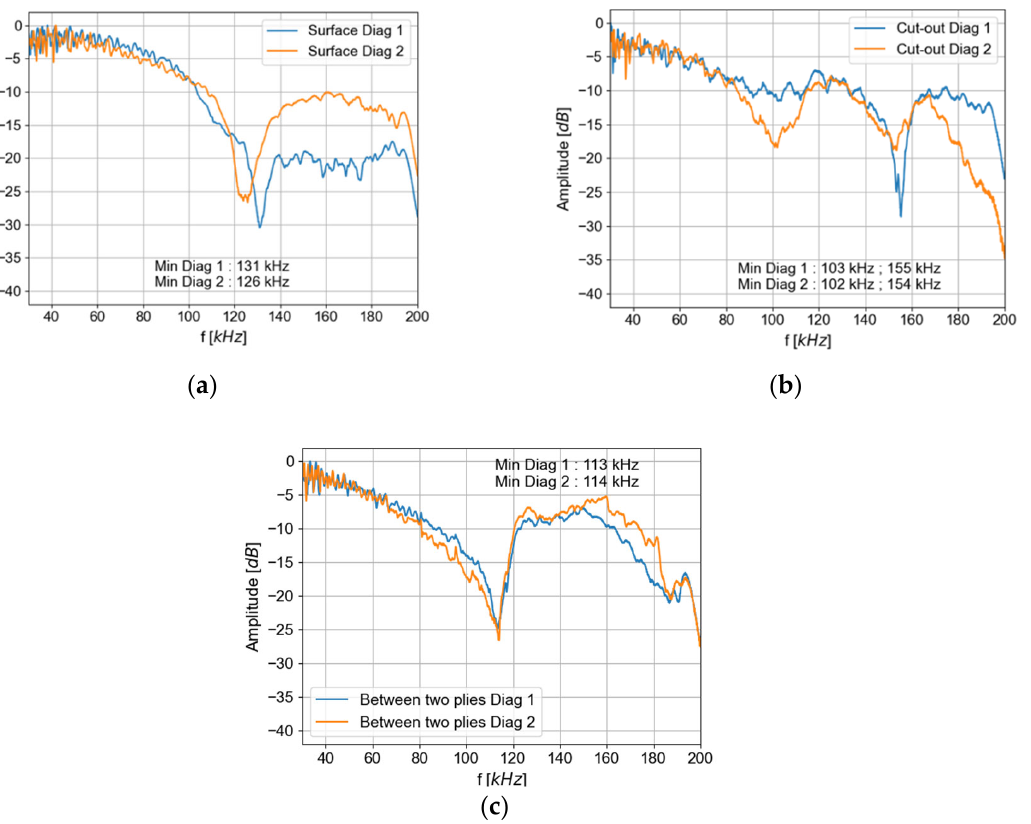
Figure 14. Maximum amplitude of the qA0 mode for a diagonal propagation for ( a ) the surface- mounted generation, ( b ) the generation with an embedded PZT transducer in the cut-out, ( c ) the generation with an embedded PZT between two plies.